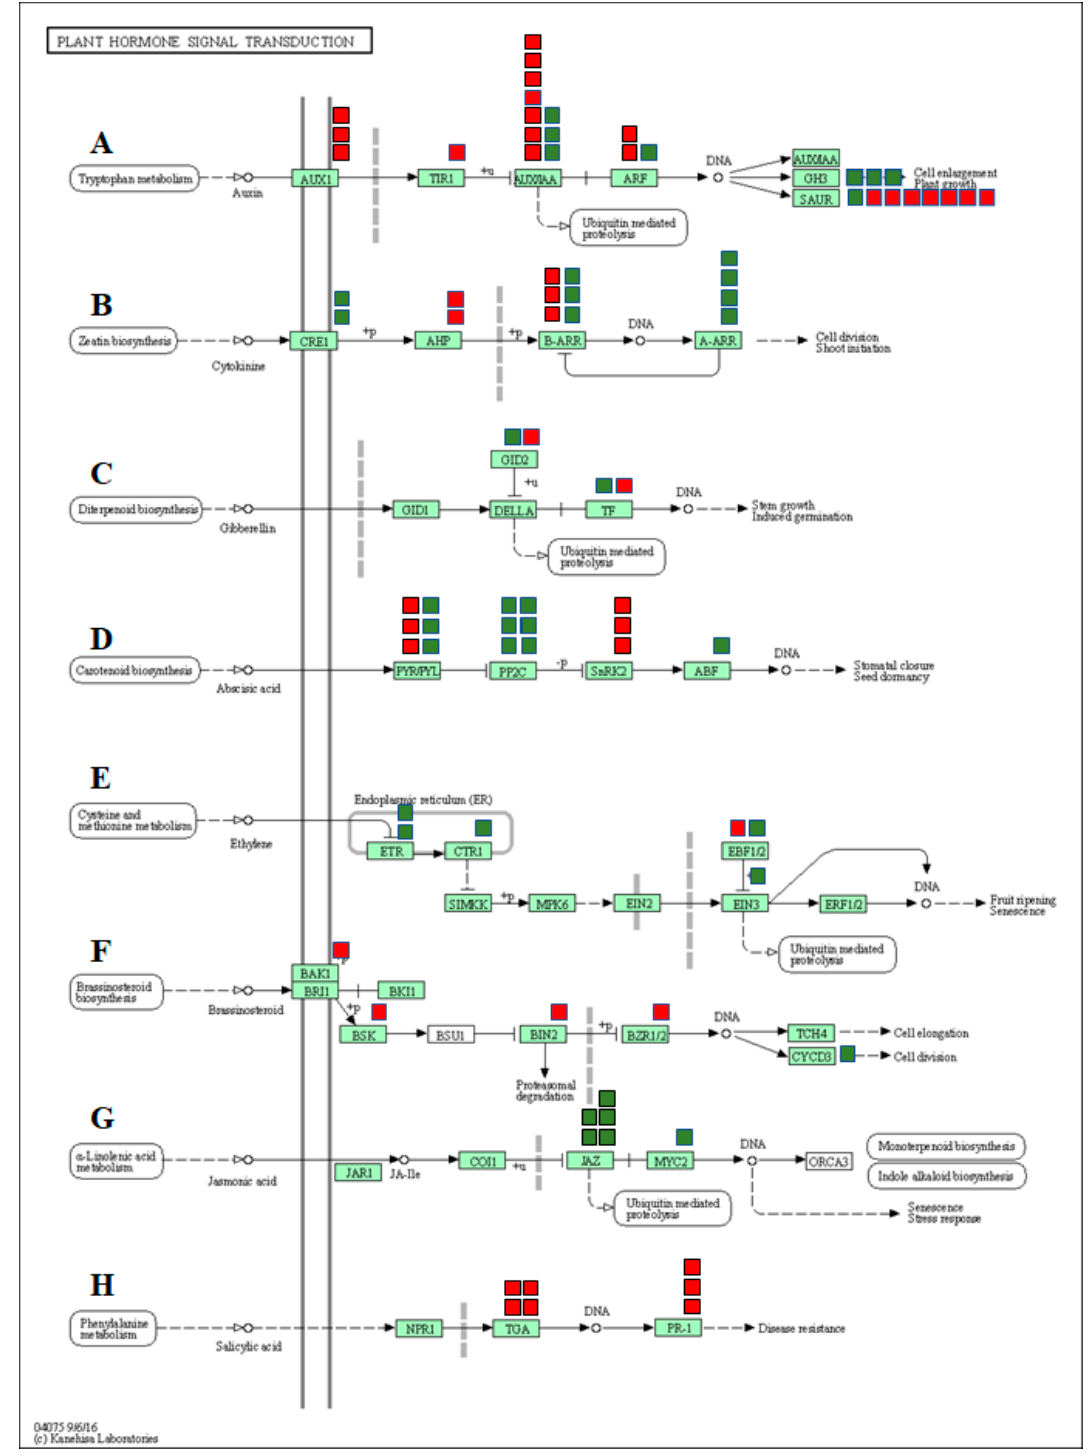
Figure 8. DEGs mapped to the plant hormone signaling transduction pathways in watermelon leaves. ( A ) Auxin signaling pathway, ( B ) cytokinin pathway, ( C ) gibberellin (GA) pathway, ( D ) abscisic acid pathway, ( E ) ethylene signaling pathway, ( F ) brassinosteroid pathway, ( G ) jasmonic acid pathway, ( H ) salicylic acid pathway. The red and green boxes show the number of down- or up-regulated DEGs, respectively.